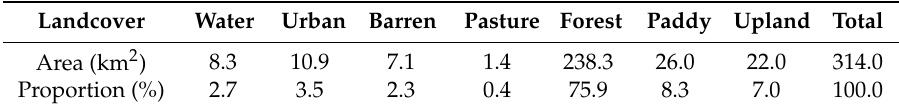
Table 1. Summary of study